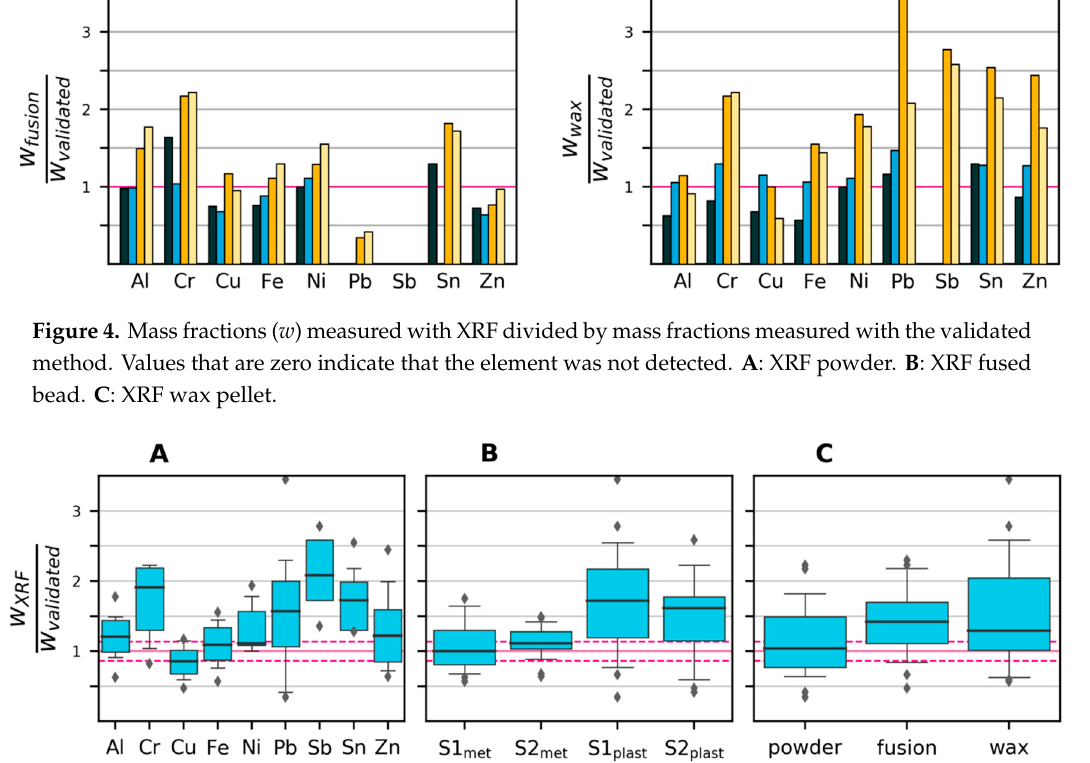
Figure 4. Mass fractions ( w ) measured with XRF divided by mass fractions measured with the validated method. Values that are zero indicate that the element was not detected. A : XRF powder. B : XRF fused bead. C : XRF wax pellet.